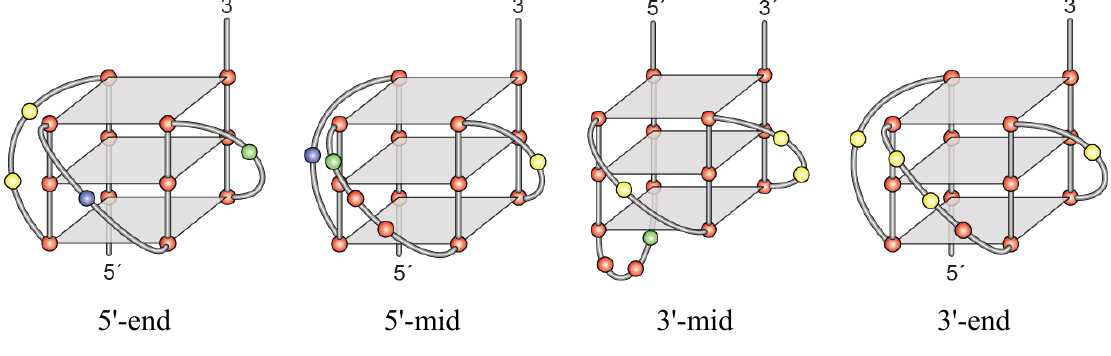
Table 1. Oligonucleotide sequences. G to T mutations are highlighted with bolded T ’s.